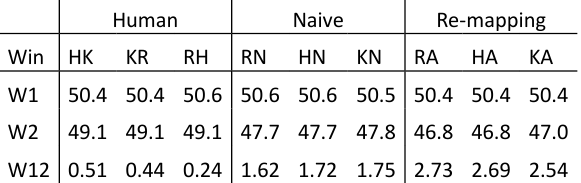
Tabel 1: Percentage of agreement between two versions of fixa- tion-to-symbol mappings in source and target